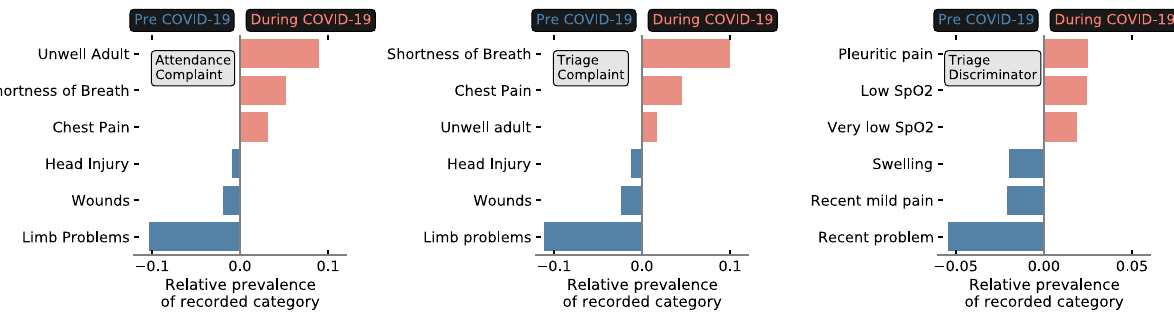
Figure 7. Relative prevalence of patient records (i.e. that indicate a patient’s symptoms) in COVID-19. Average prevalence of recorded categories during COVID-19 (relative to pre COVID-19) recorded under attendance complaint (left), triage complaint (middle), and, triage discriminator (right). A higher (lower) value corresponds to a more prevalent complaint during (pre)